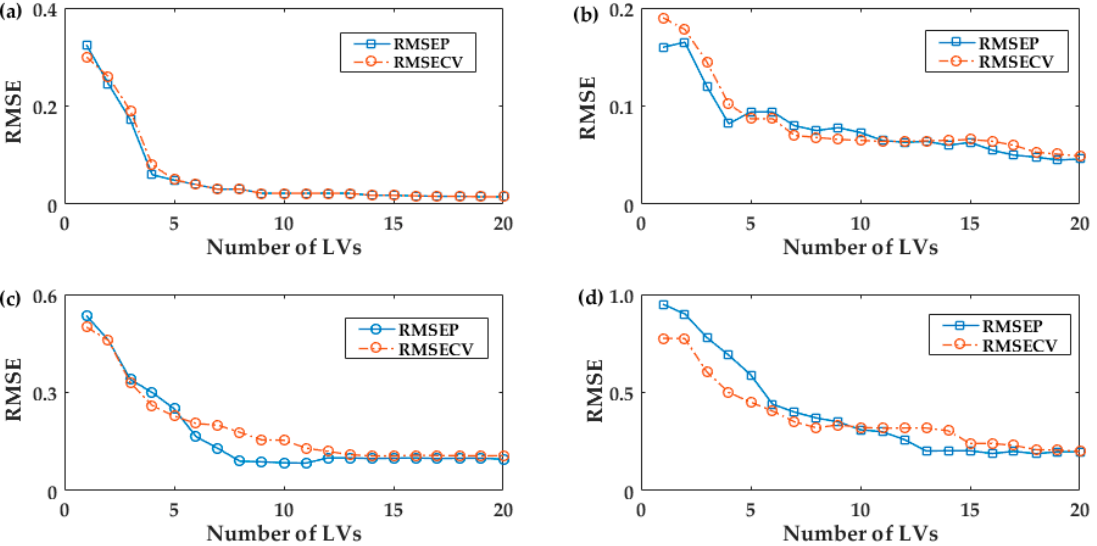
Figure 3. RMSE of PLS models with different numbers of LVs for ( a ) moisture, ( b ) oil, ( c ) protein, and ( d ) starch of corn. Note: RMSECV: root mean squared errors of cross-validation; RMSEP: root mean squared errors of prediction; RMSE: root mean squared errors; LVs: latent variables;